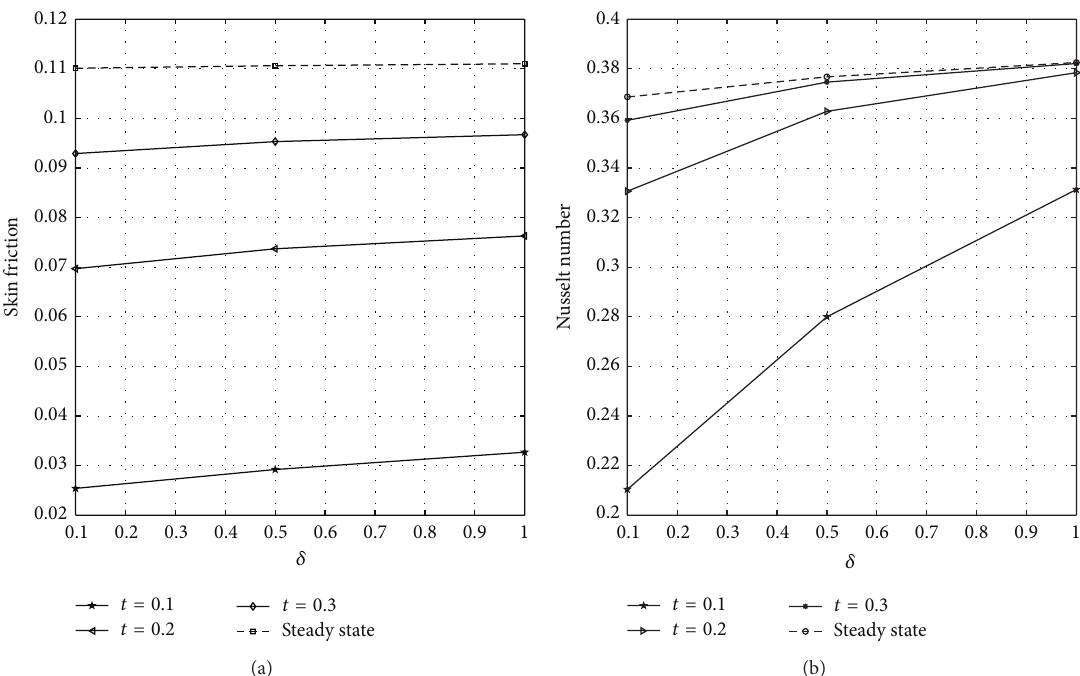
Figure 12: Variation of skin friction and Nusselt number with 𝛿 and time ( 𝑡 ) at 𝑦 = 1